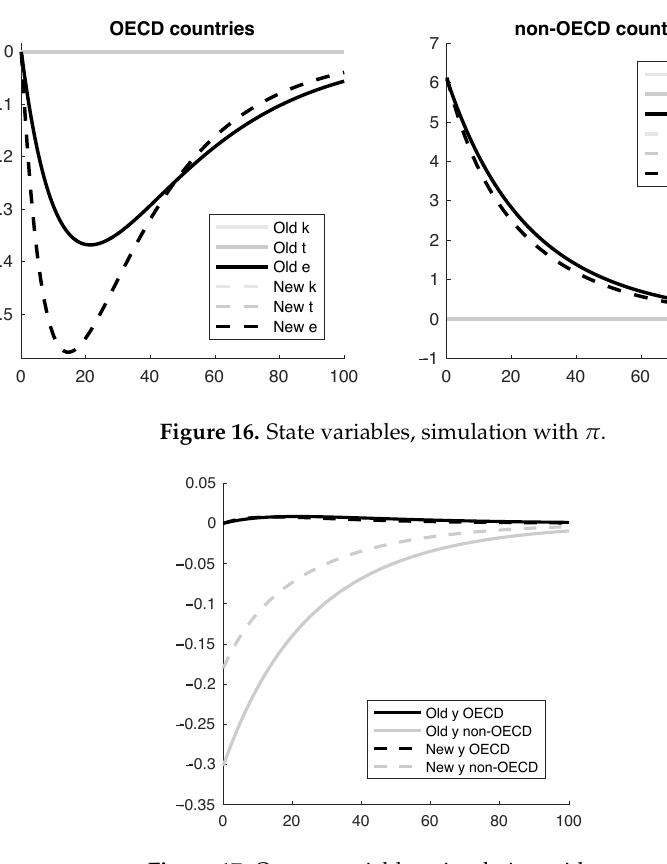
Figure 17. Output variables, simulation with π